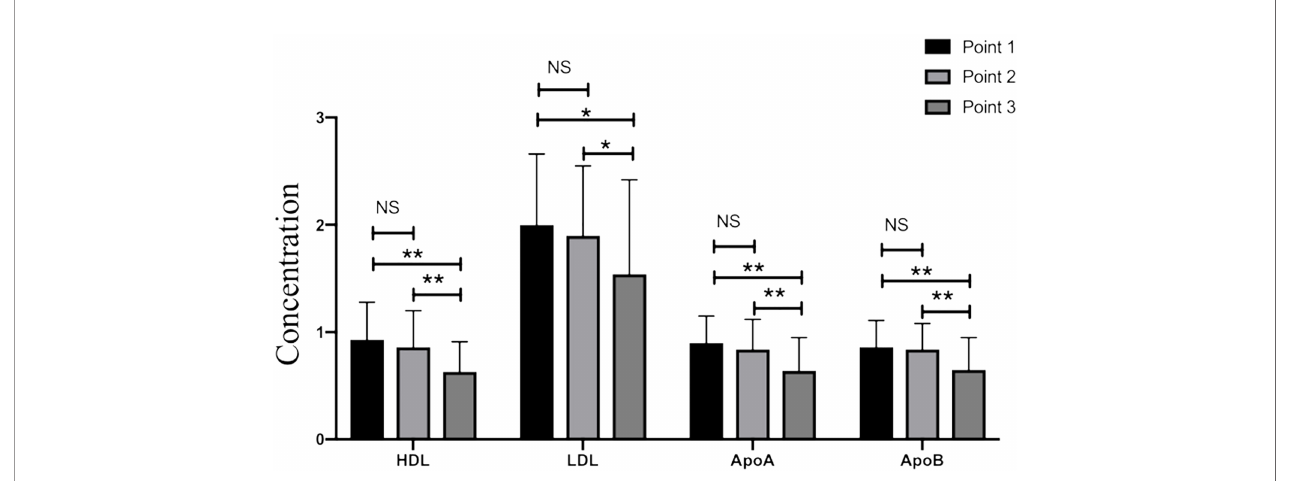
FIGURE 1 | The levels of HDL-c, LDL-c, ApoA, and ApoB in critical patients with COVID-19. Point 1: on admission day; Point 2: day 2-3 after the admission; Point 3: last test before achievement of clinical outcome. NS: p > 0.05; *: p < 0.05; **: p <